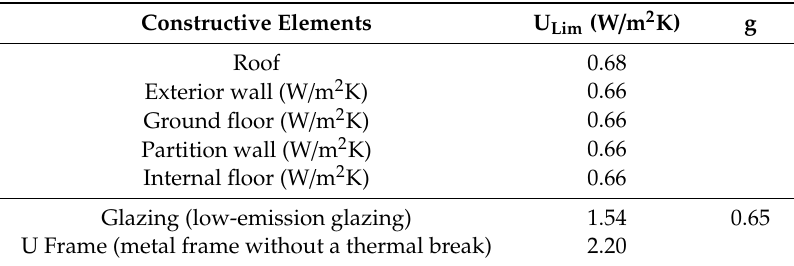
Table 2. Design data of the building envelope of Case 2006. The limit values of the overall heat transfer coe ffi cient of the building envelopes for both normative